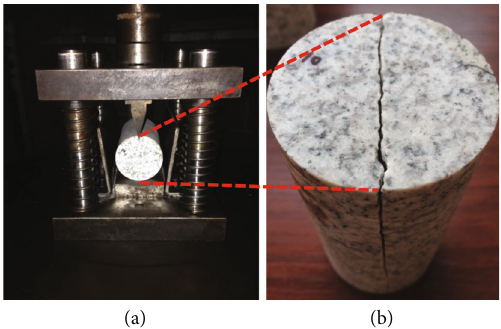
Figure 1: (a) The splitting tool and (b) a single fractured granite